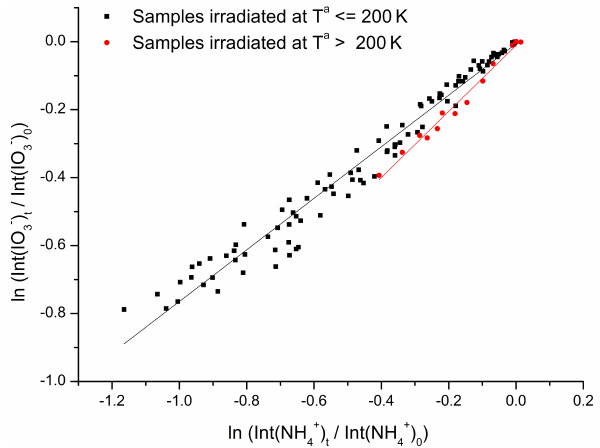
Figure 4. Natural logarithm of the integrated intensities (in arbitrary units) of the ν 3 of IO − at different times of irradiation divided by 3 that at t = 0 vs. the equivalent magnitude for the ν 4 band of NH + for all samples of ammonium iodate shown in Table 2. Samples irradiated at T ≤ 200K and T > 200K are shown in black and red,